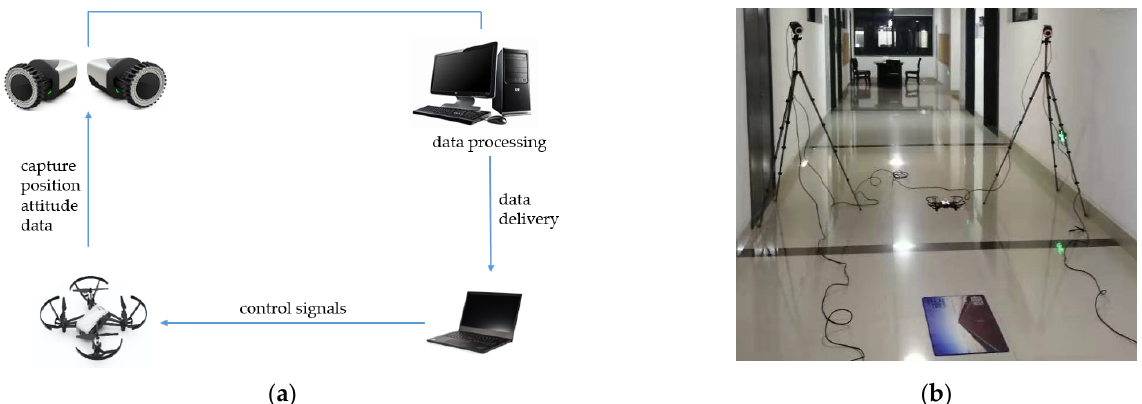
Figure 10. Experimental process using a Tello quadrotor.